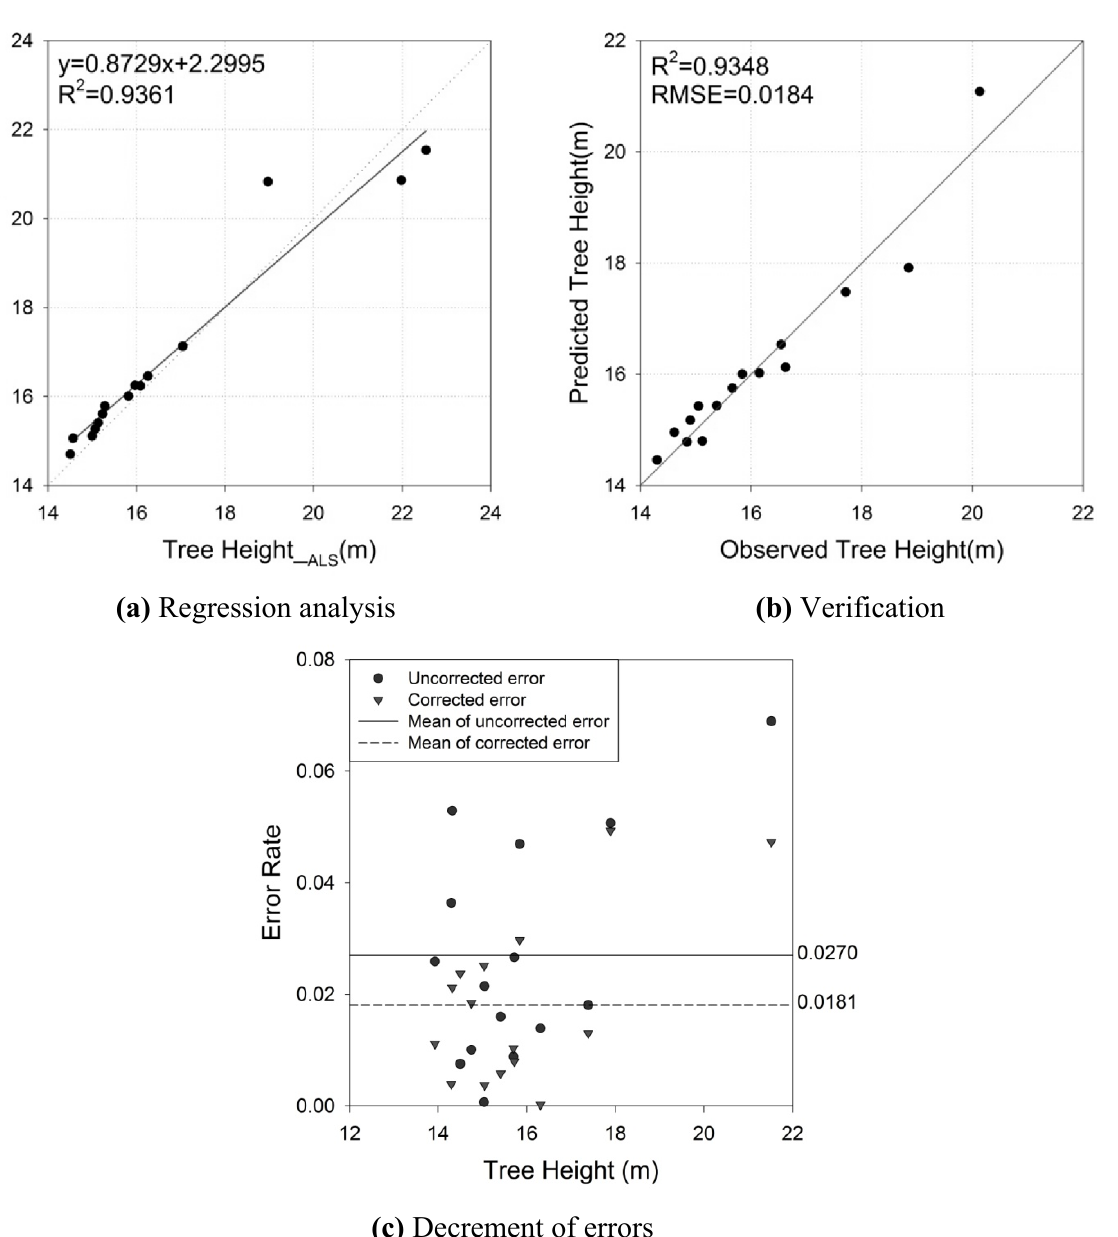
Figure 6. Reduction of TH-estimate errors through the regression